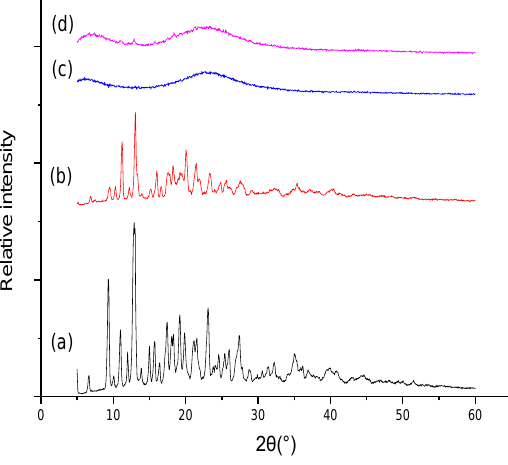
Figure 2. X-ray diffraction (XRD) spectra of β-CD (a), 6-EA-β-CD (b), Cl-Si (c) and 6-EA-β-CD-Si (d).